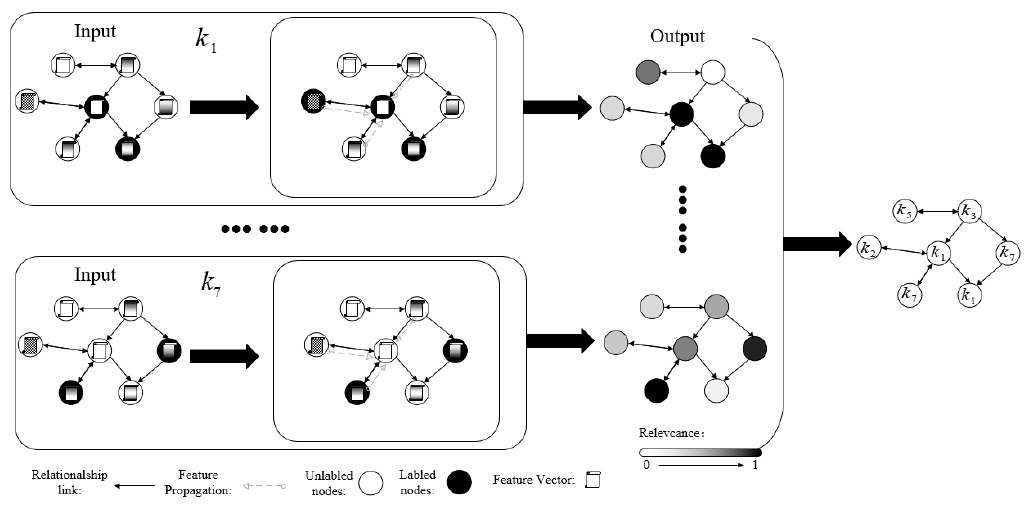
Figure 2. Framework architecture.